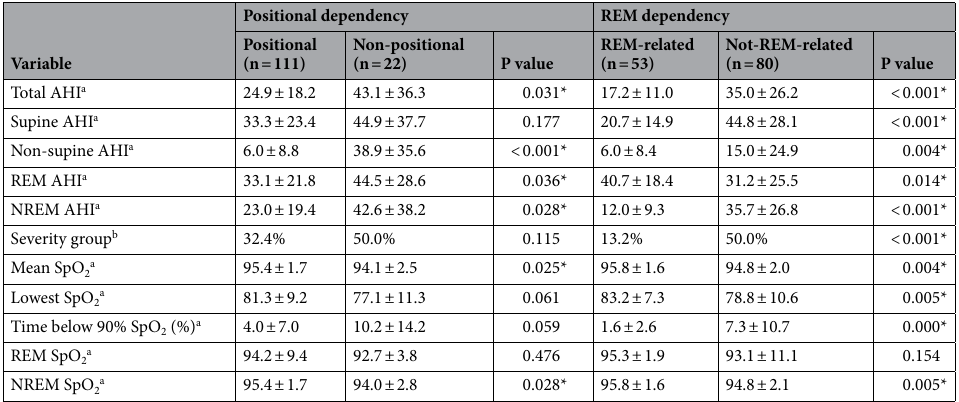
Table 3. Polysomnographic characteristics according to positional and REM dependency- respiratory parameters. REM, rapid eye movement sleep; AHI, apnea–hypopnea index; NREM, non-rapid eye movement sleep. a Results were obtained from independent T-test: mean ± SD. b Results were obtained from Chi-square test. *Significant difference: p <